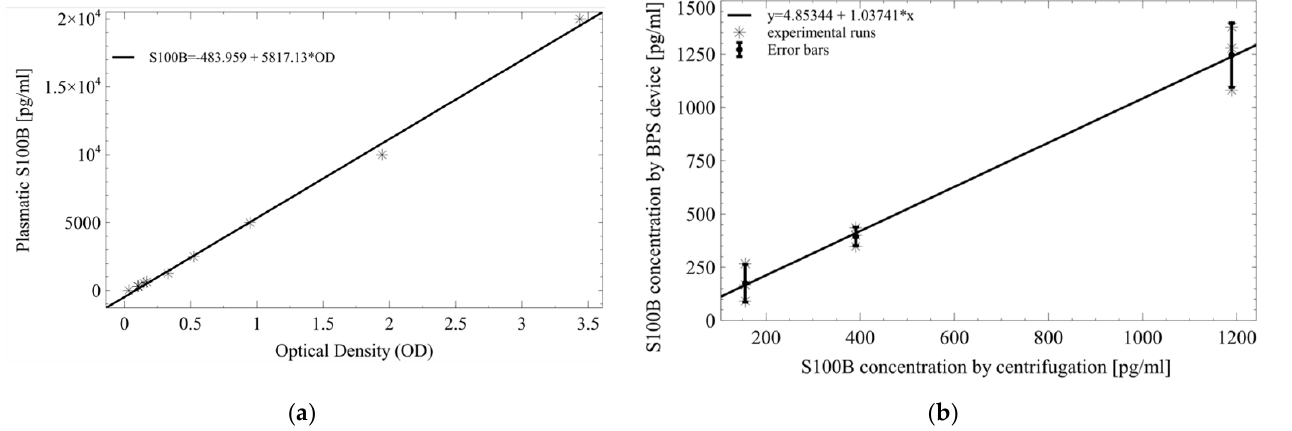
Figure 7. Regression models for the ELISA test. ( a ) Calibration curve for standard ELISA measure- ments. ( b ) Correlation model for S100B detection values obtained using centrifugation and the BPS device.